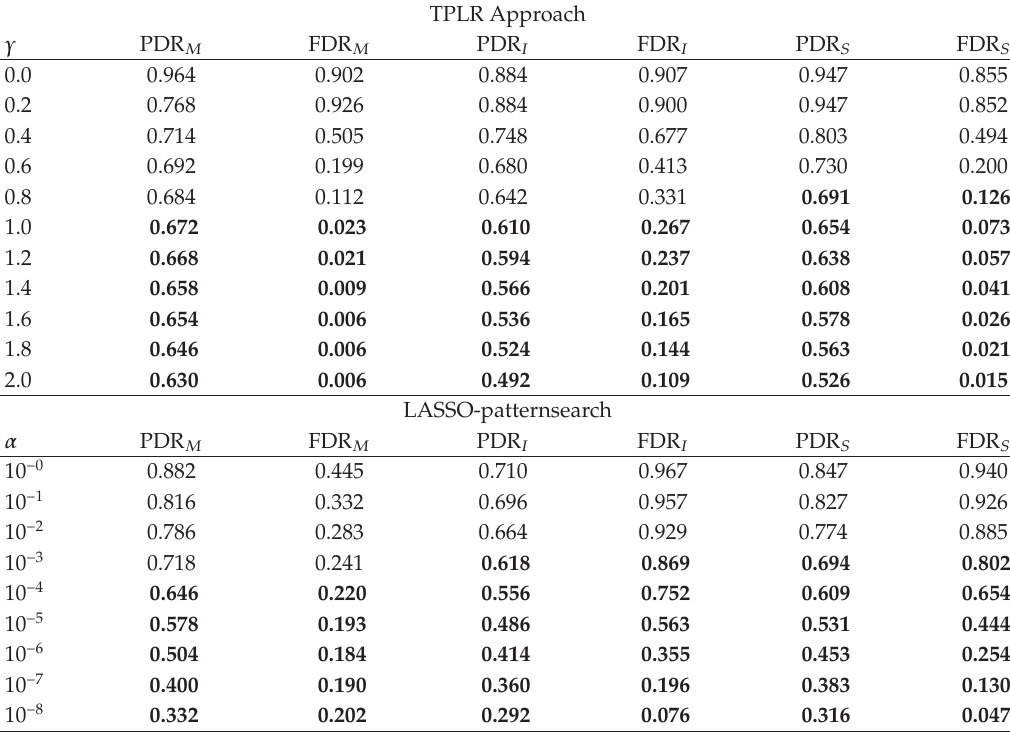
Table 6: Comparison of TPLR approach and LASSO-patternsearch (cid:3) the PDR and FDR with subscript M , I , and S indicate the rates calculated for main-e ff ect features, interaction features, and SNPs resp.